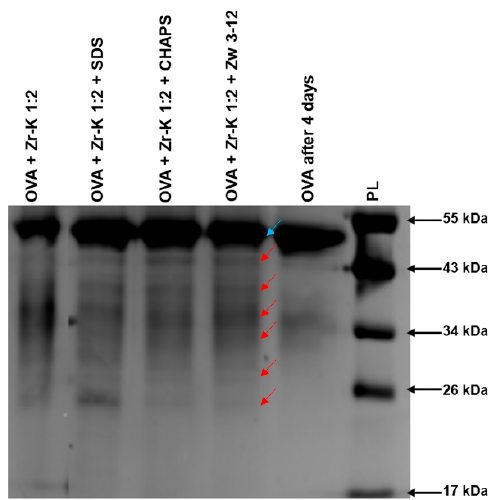
Figure 3. Silver-stained SDS-PAGE gel for the hydrolysis of 40 µ M of OVA by 2 mM of Zr-K 1:2 at 60 °C after 4 days at pH 7.4 (10 mM sodium phosphate buffer) in the absence and presence of different surfactants. The values on the right side of the gel indicate the Mw reference in kDa. The blue (top) and red arrows indicate the intact protein and the hydrolytic fragments, respectively. The content of each lane is shown on top of the gel, and the concentration of each surfactant was 0.5 wt%. PL stands for protein ladder.